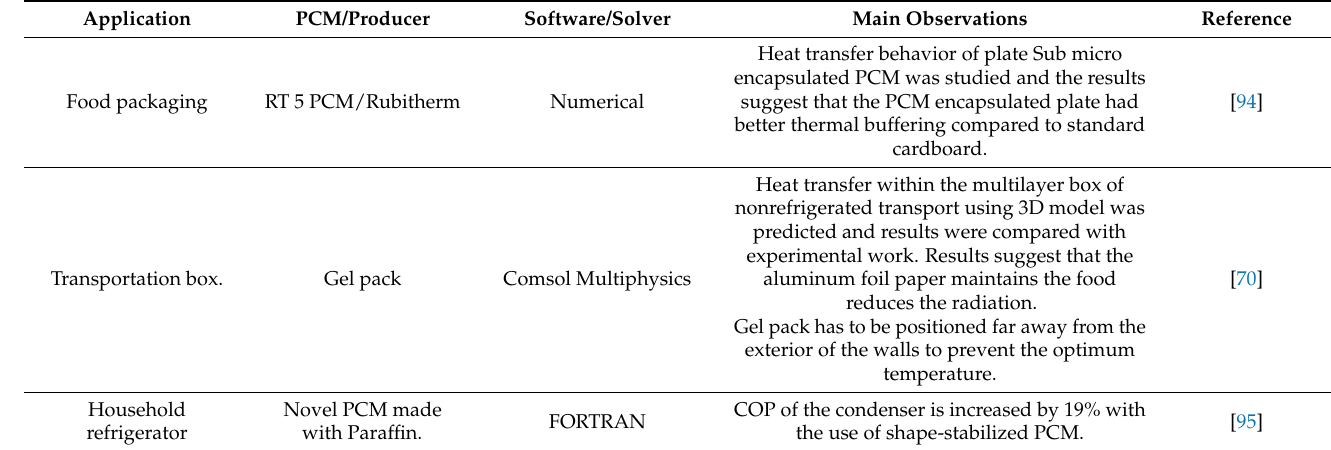
Table 7. Summary of studies reported with the use of PCM in various applications using